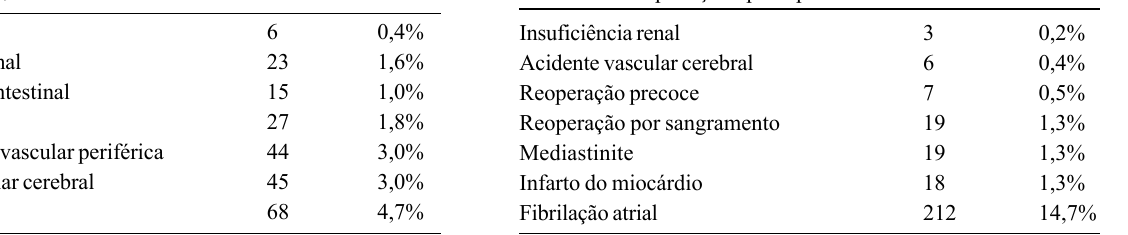
Tabela 1. Doenças associadas. Tabela 2. Complicações